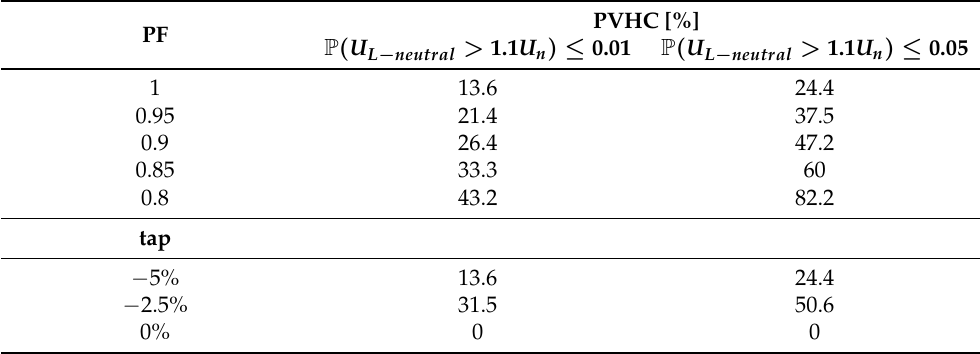
Table 4. Differences in PVHC results due to different limit